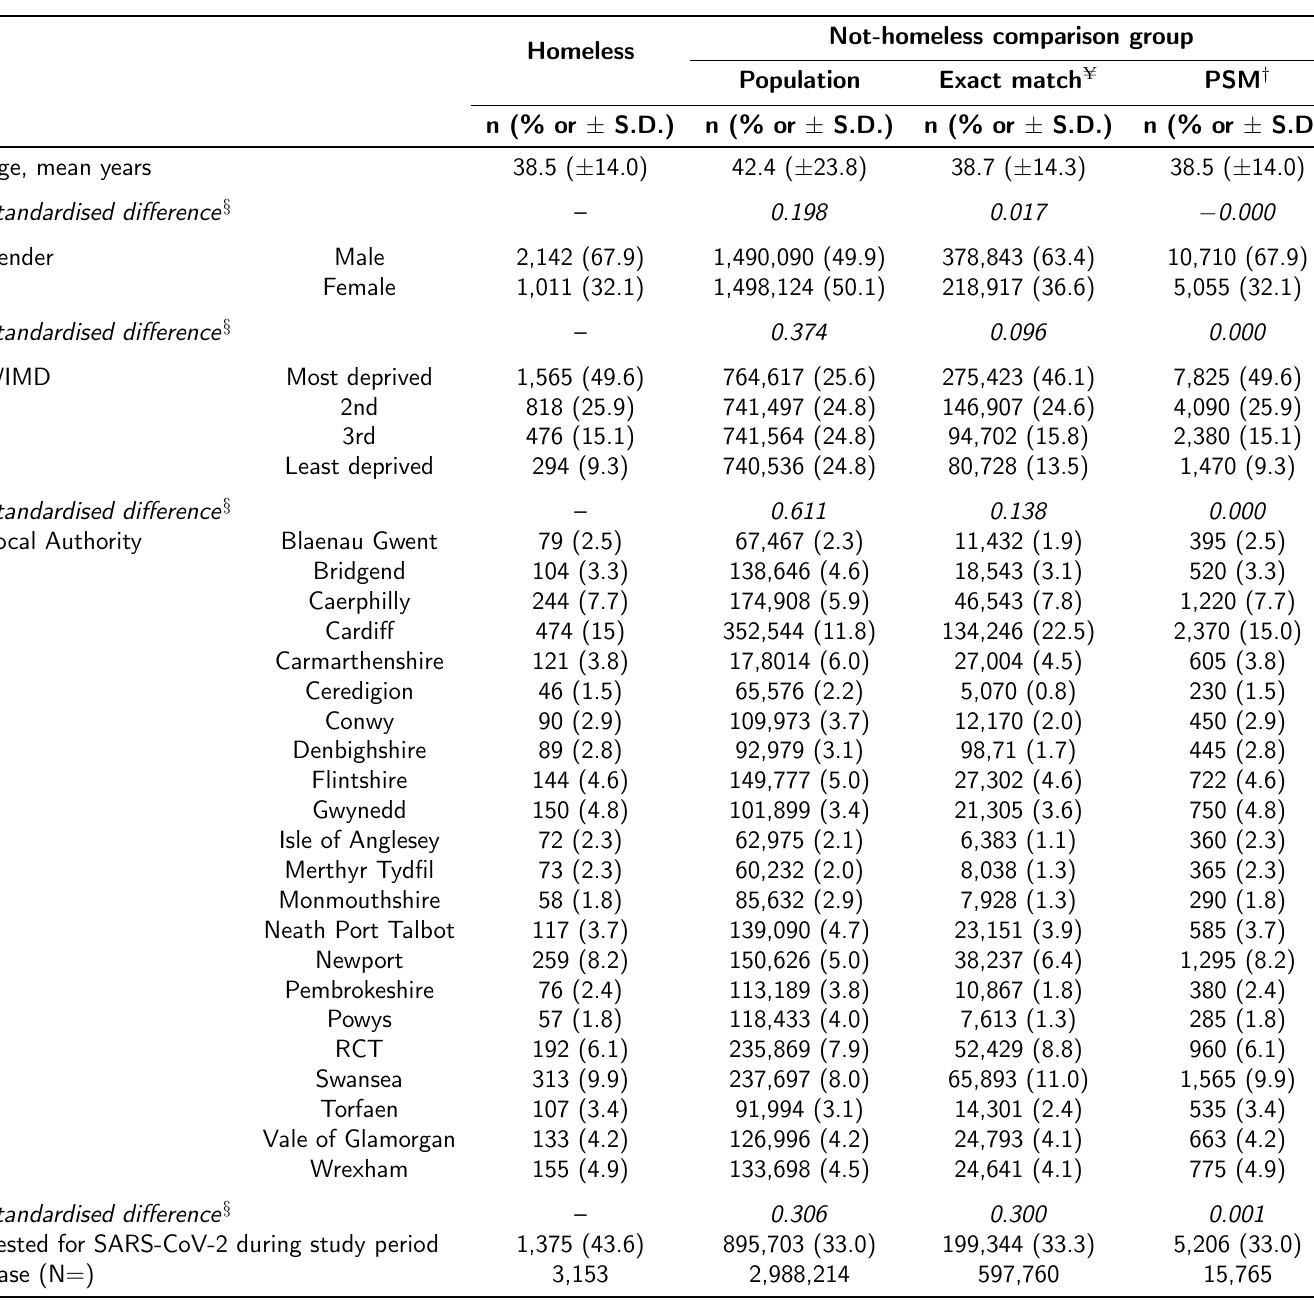
Not-homeless comparison